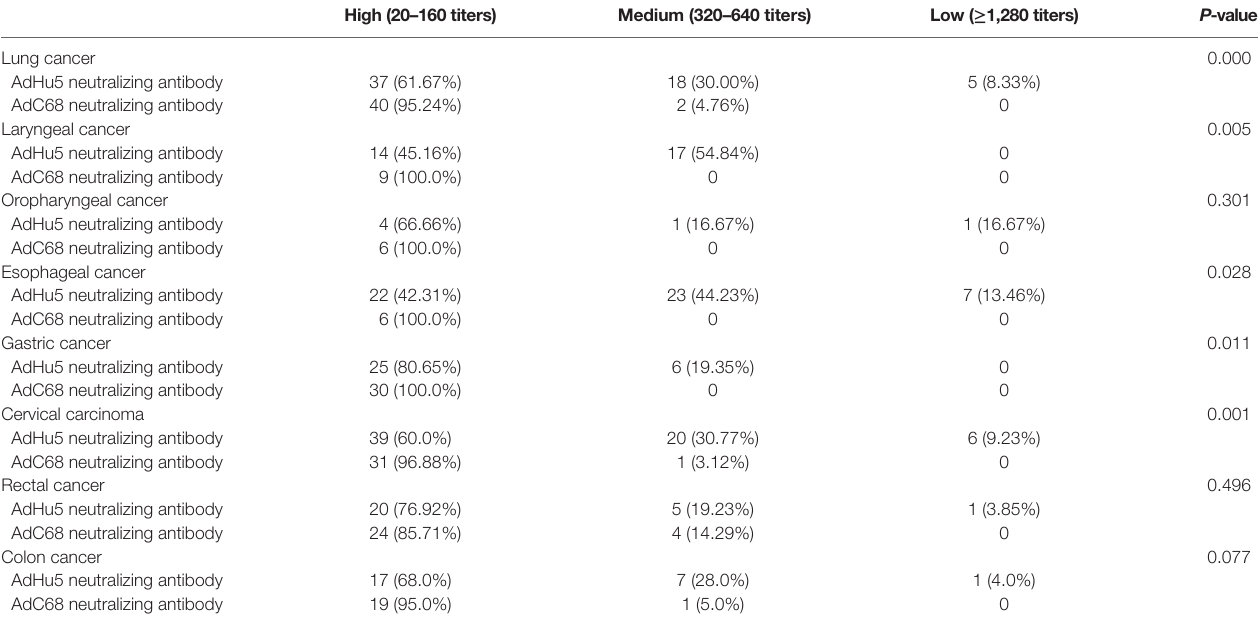
Table 4 | Distribution of AdHu5 and AdC68 neutralizing antibody titers in positive samples from subjects from different type of cancer.